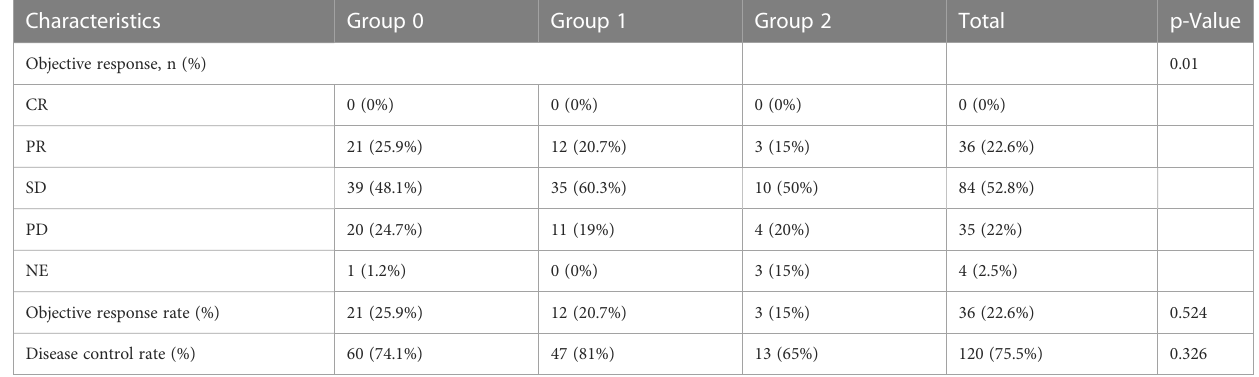
TABLE 2 Response evaluation between the three GRIm-Score groups of the entire cohort.